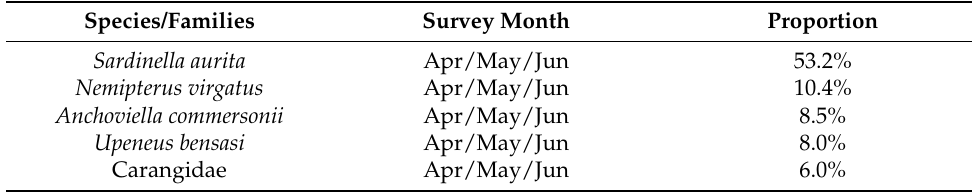
Table 1. Major catch species and their